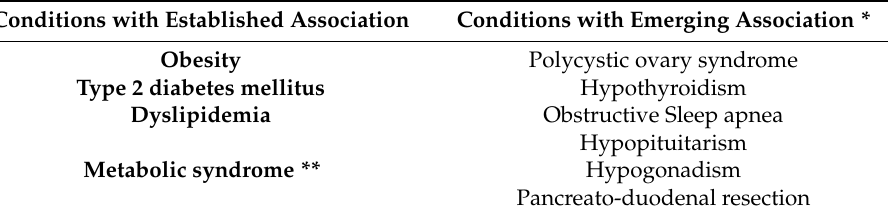
Table 1. Risk Factors Associated with nonalcoholic fatty liver disease (NAFLD)